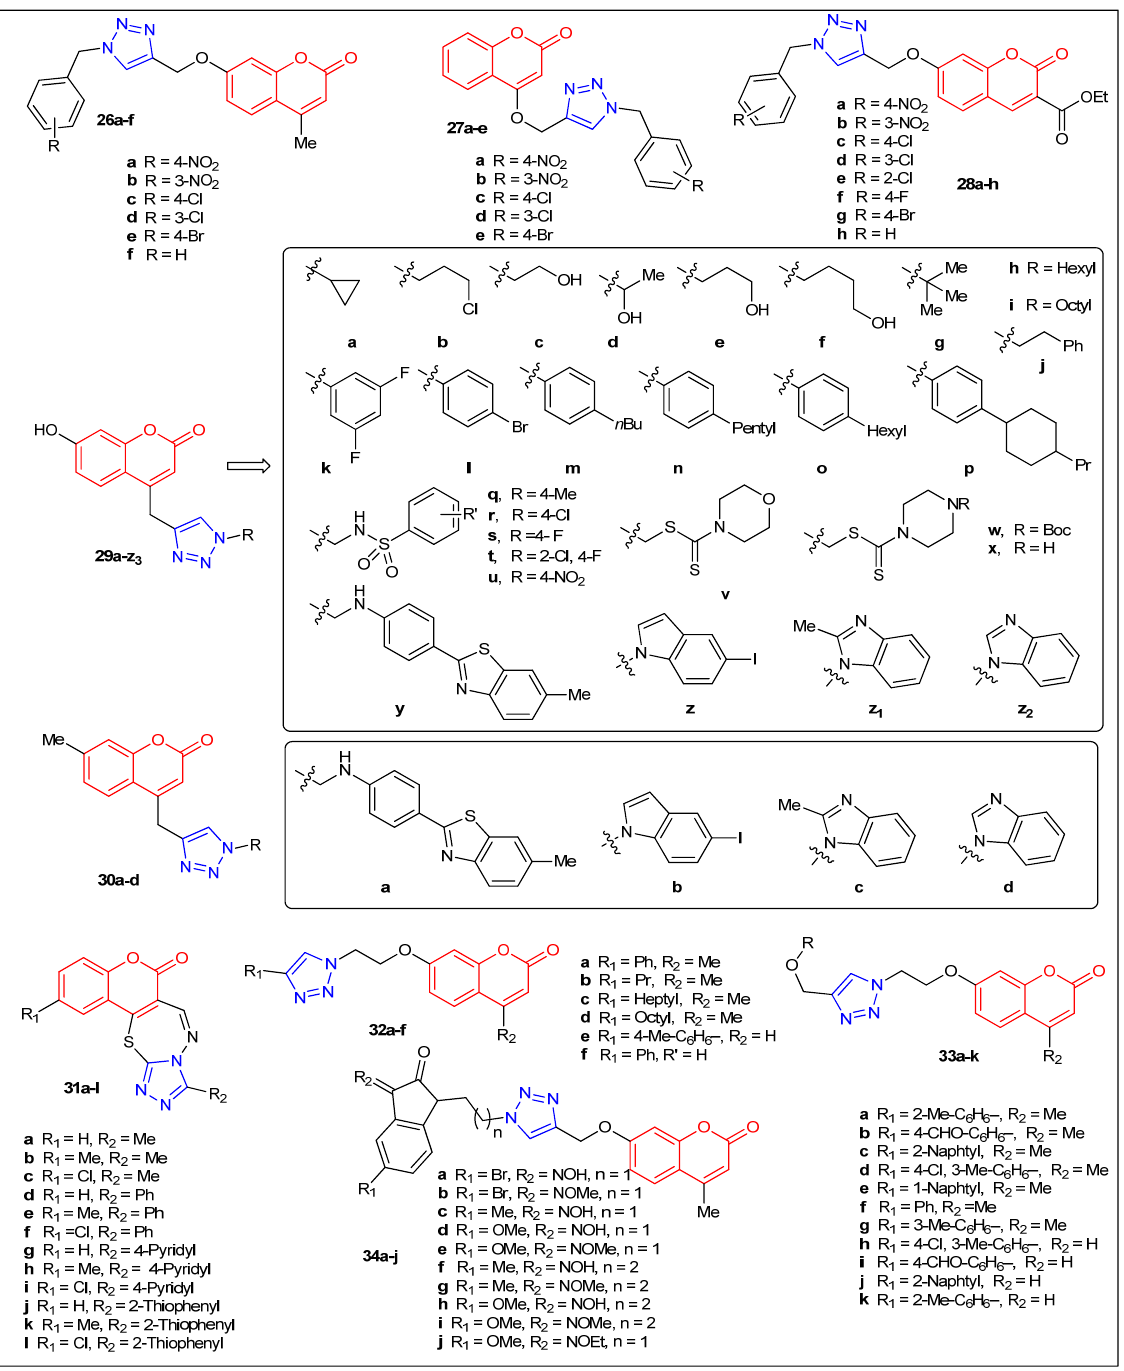
Figure 5. Structures of the reported coumarin triazole derivatives from 2016 – 2017 .